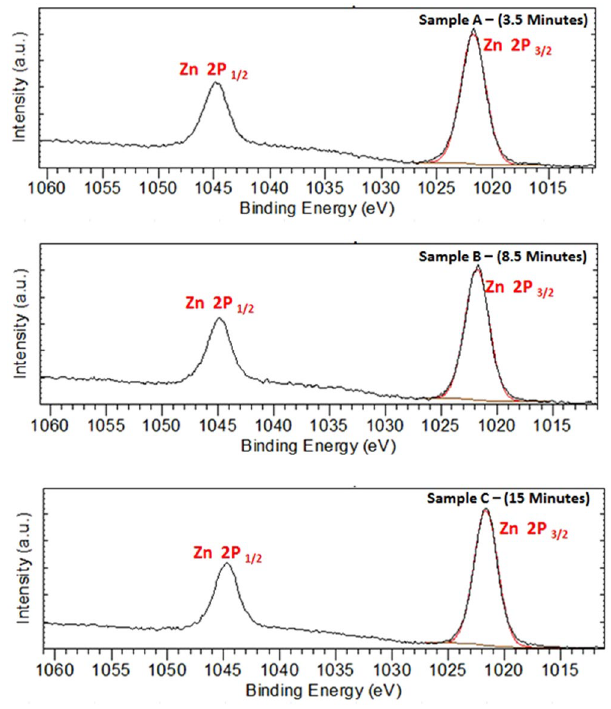
Figure 22. Zn 2p XPS double spectra of ZnO for samples picked up at ( a ) 3.5 minutes, ( b ) 8.5 minutes, and ( c ) 15 minutes after starting of the